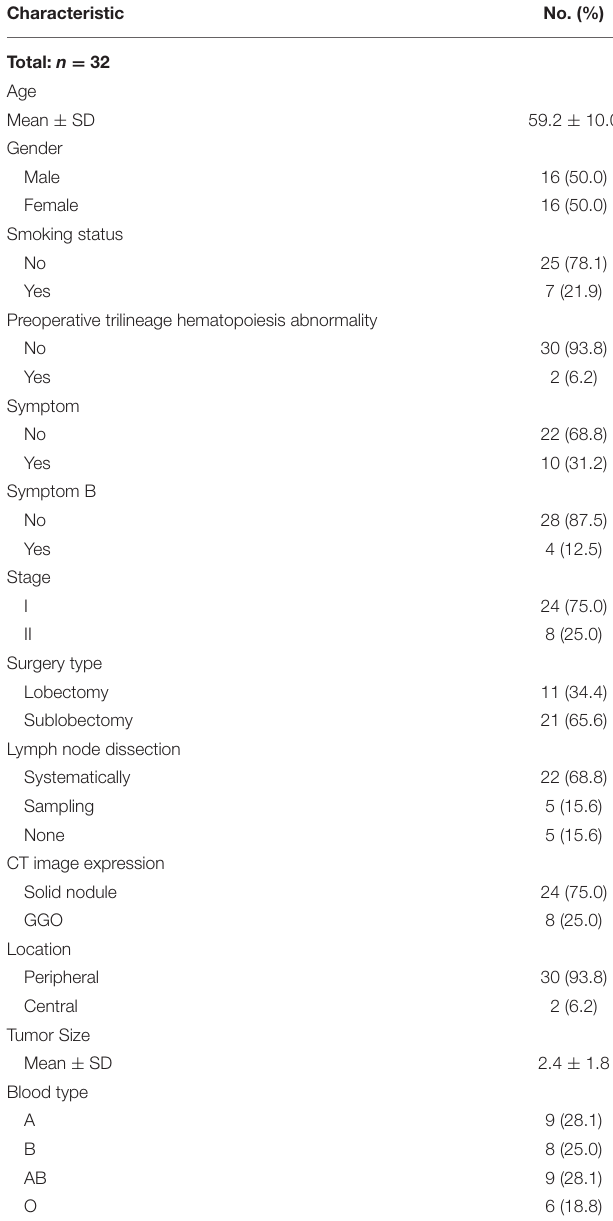
TABLE 1 | Clinical characteristics of patients with primary pulmonary mucosa-associated lymphoid tissue (MALT) lymphoma.